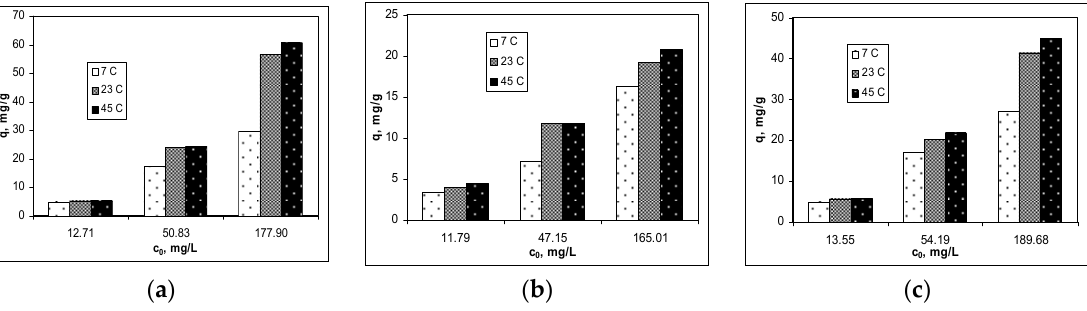
Figure 2. Influence of temperature on the biosorption efficiency of: ( a ) Cu(II), ( b ) Co(II) and ( c ) Zn(II) ions on alginate.